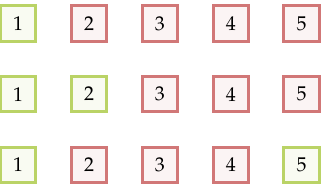
Figure 9. Example of rank lists of queries and the returned ranked gallery sample. Green means a correct match, and red means the wrong matching. For all rank lists, the CMCs are 1 while the AP are 1, 1 and 0.7.